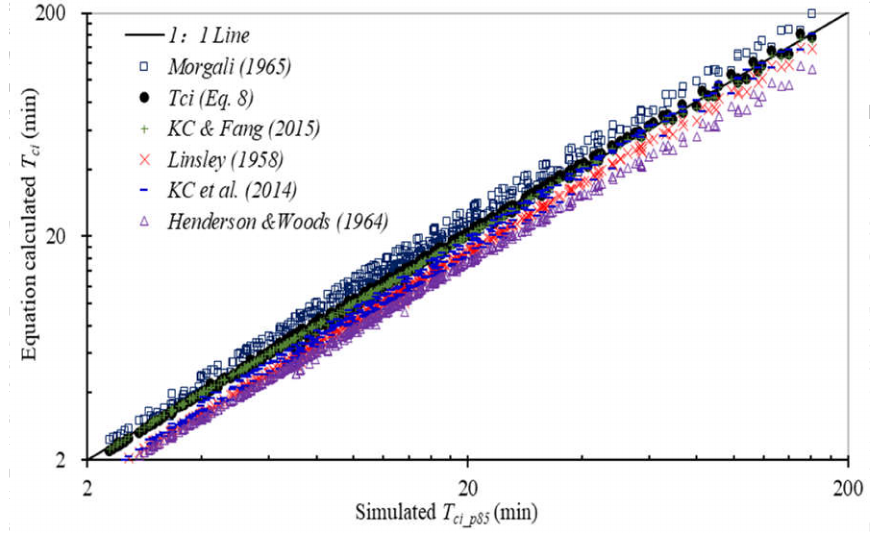
Figure 5. T ci calculated from six equations (Table 2) versus simulated T ci_p85 for 446 modeling cases of impervious